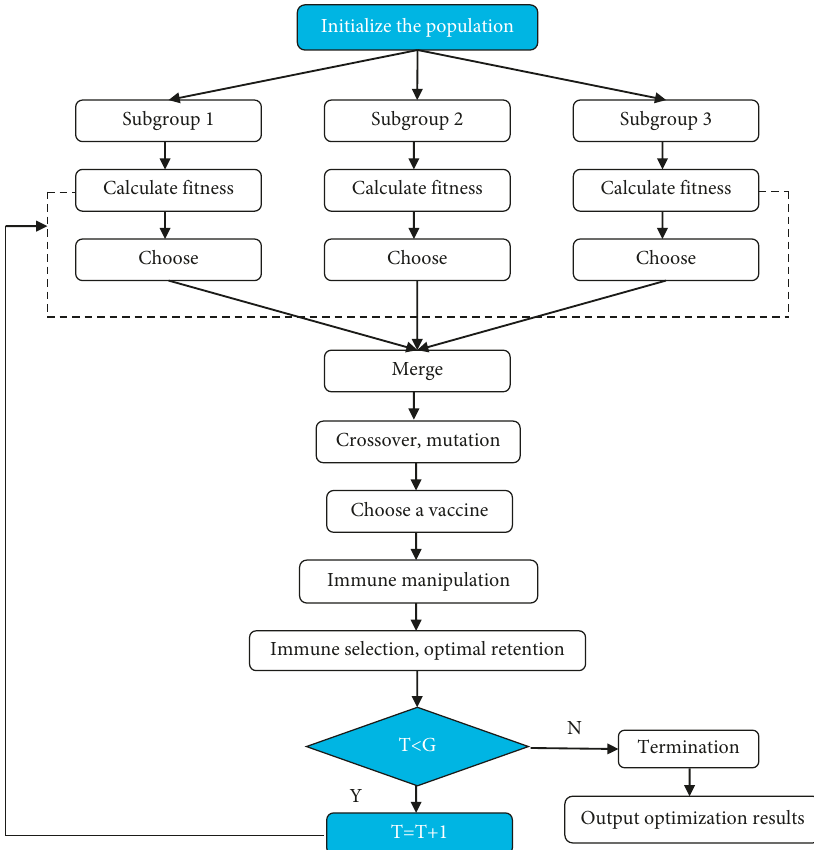
Figure 3: AIGA multiobjective optimization